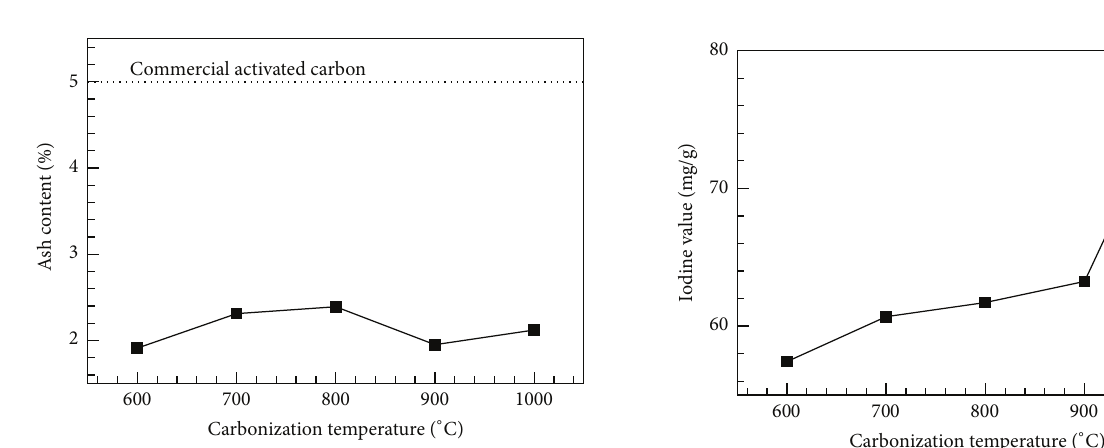
Figure 7: Iodine adsorption quantity as a function of carbonization